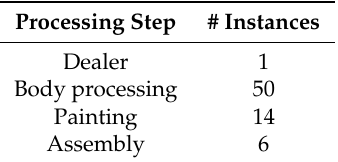
Table 4. New instance